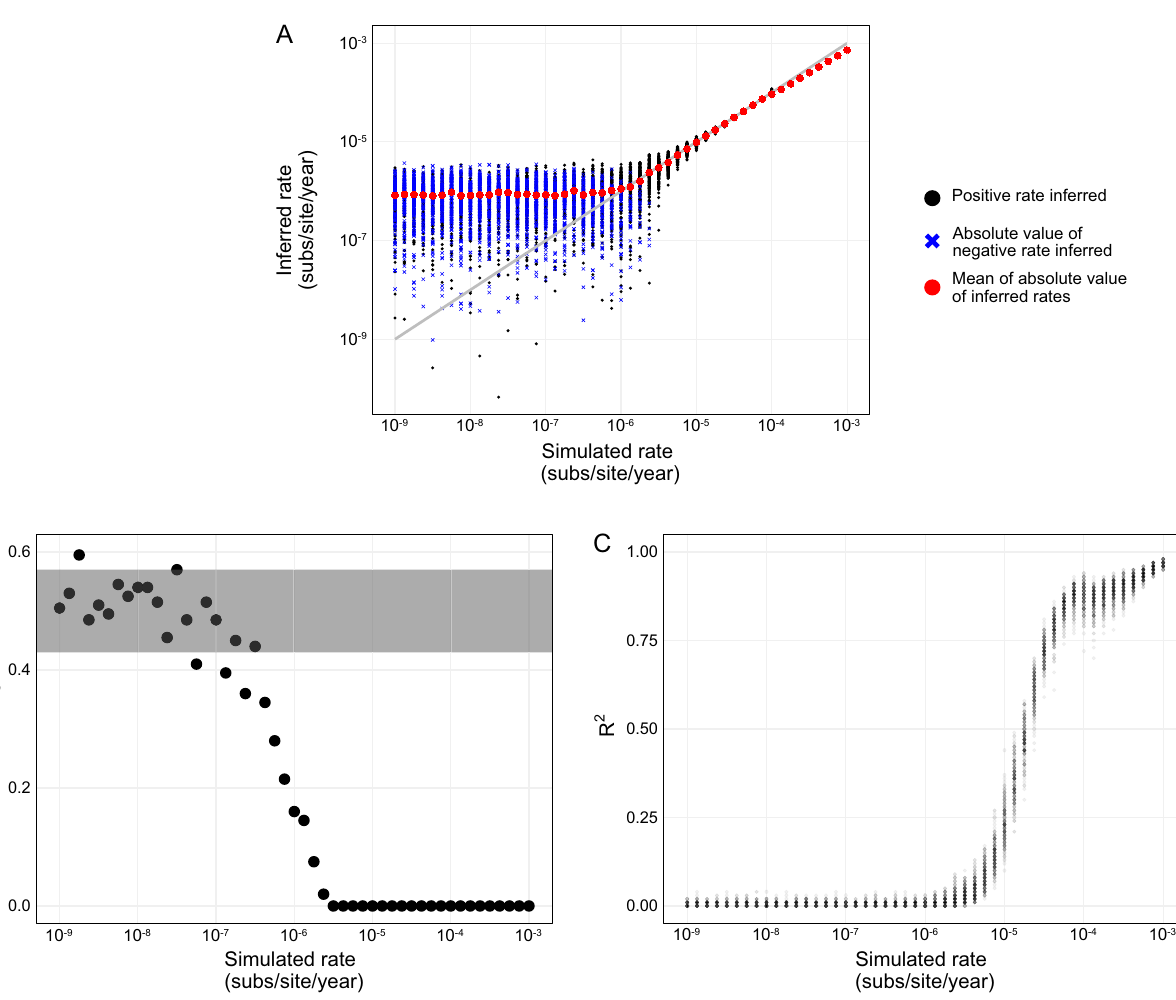
Fig. 3 | Performance of clock rate inference on simulated data. A Inference of clockratefora fi xedinputtreewithsimulatedsequencesandempiricaldates.Black dotrepresentsestimatesofpositiverates,abluexrepresentstheabsolutevalueof estimates of negative rates, and red dots indicate the mean of absolute value for each fi xed rate. Gray line indicates parity of simulated and estimated rate. B Negativeclockrateanalysisofthefractionoftotalsimulationsfora fi xedratethat